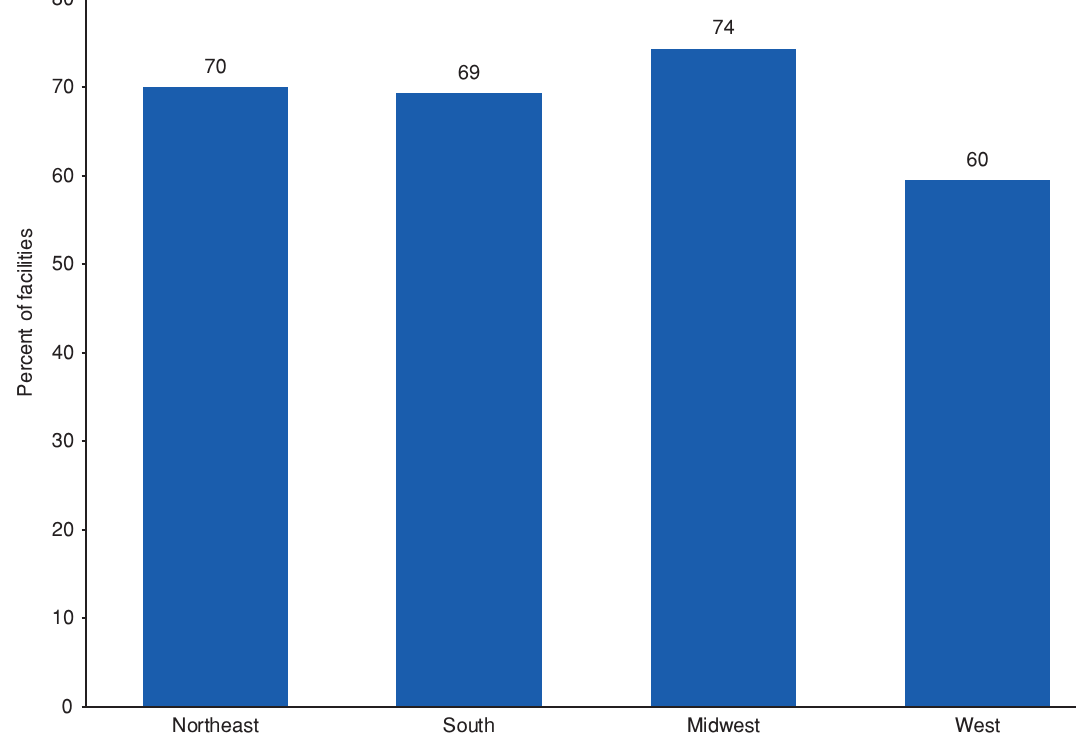
Figure 14. Mental health treatment facilities accepting Medicare, by region: